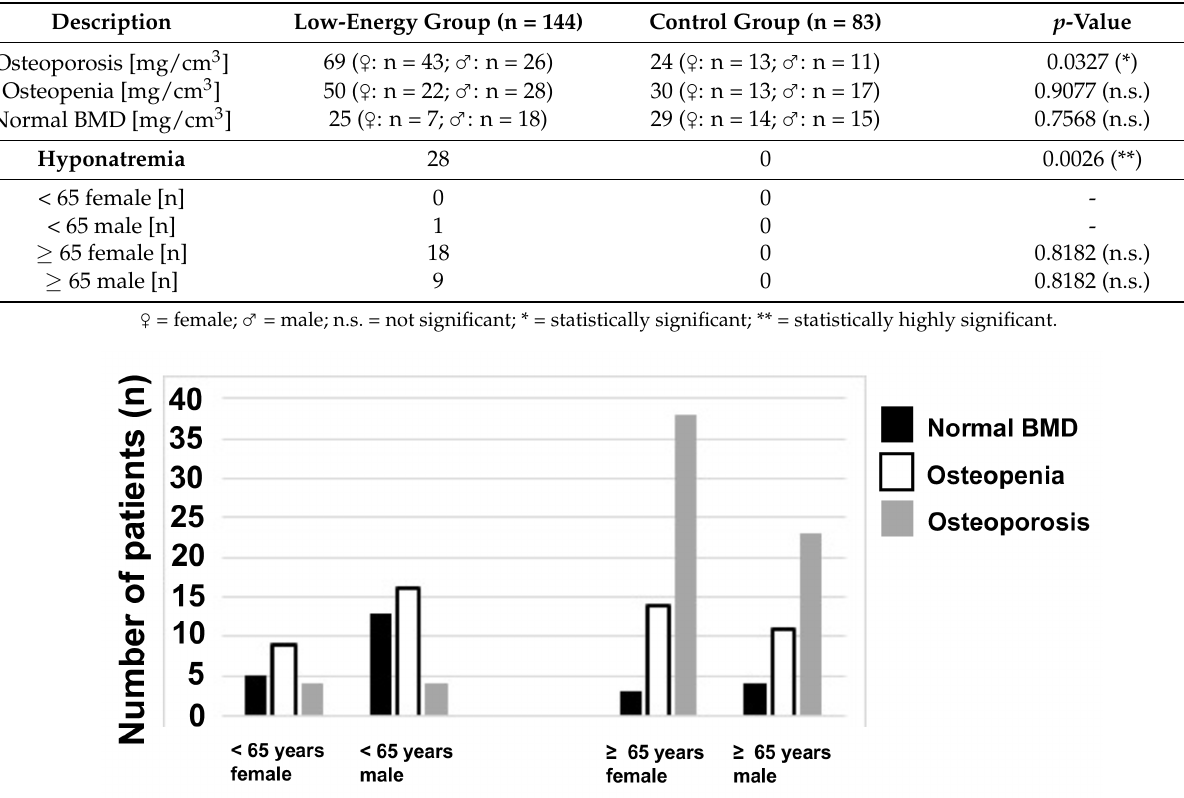
Figure 2. Distribution of bone mineral density (BMD) between the two age cohorts younger than 65 years and ≥ 65 years. Black bars show normal BMD, white bars show osteopenia, and grey bars indicate osteoporosis. Number of patients is indicated on the y-axis (n) and the different age groups (i.e., patients who are younger than 65 years and 65 years or older, respectively) are presented on the x-axis.